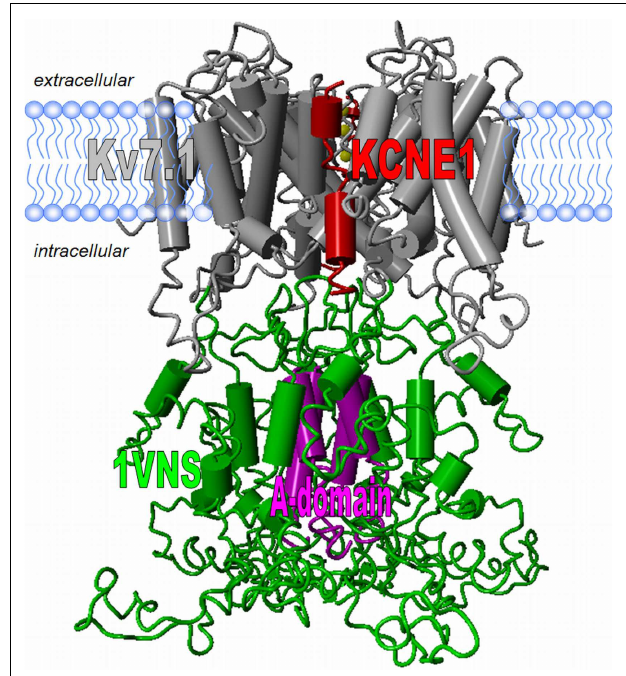
FIGURE 4 | Structural model of the Kv7.1 channel. The transmembrane domain of the Kv7.1 channel bears the common Kv channel structure. Homology models using the solved crystal structural constraints allow for good model predictions (gray). For docking experiments the solved NMR-structural data of the full-length KCNE1 in lipid environments can be used (here only the transmembrane segment is shown in red;Tian et al., 2007; Kang et al., 2008).The structure of the Kv7.1 tetrameric assembly domain (A-domain) was solved and can be incorporated into a model (Xu and Minor, 2009).The region linking the S6 and the A-domain shows amino acid similarity to the structure 1VNS.pdb. No structures or even template coordinates for the Kv7.1 N-terminus and the distal C-terminus are available and thus homology modeling is currently